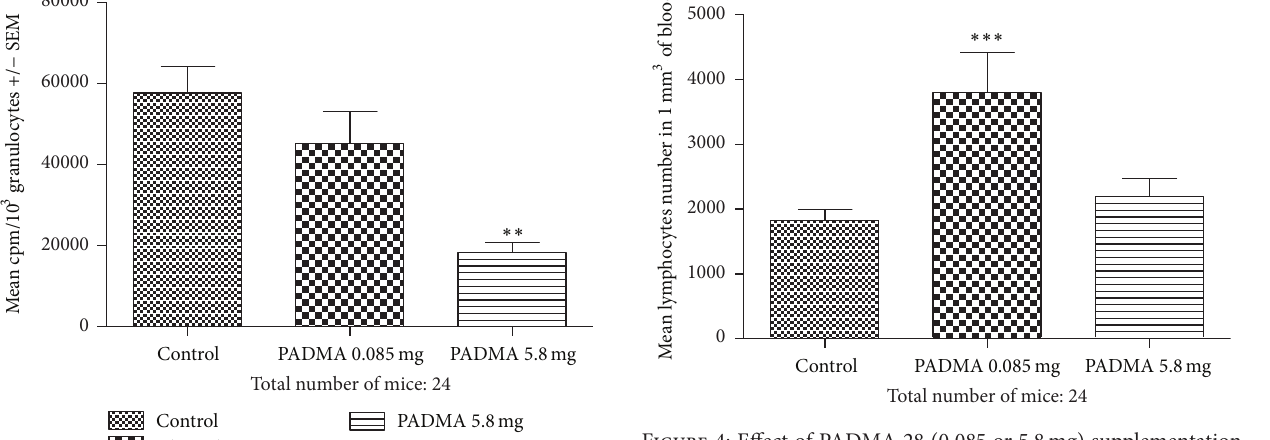
Figure 4: Effect of PADMA 28 (0.085 or 5.8 mg) supplementation on the number of blood lymphocytes in mice. Balb/c mice were fed daily with 0.085 mg or 5.8mg of PADMA 28. After 7 days mice were bled and sacrificed. Counting of leukocytes and blood smears examination were performed by routine methods. ∗∗∗ 𝑃 < 0.001